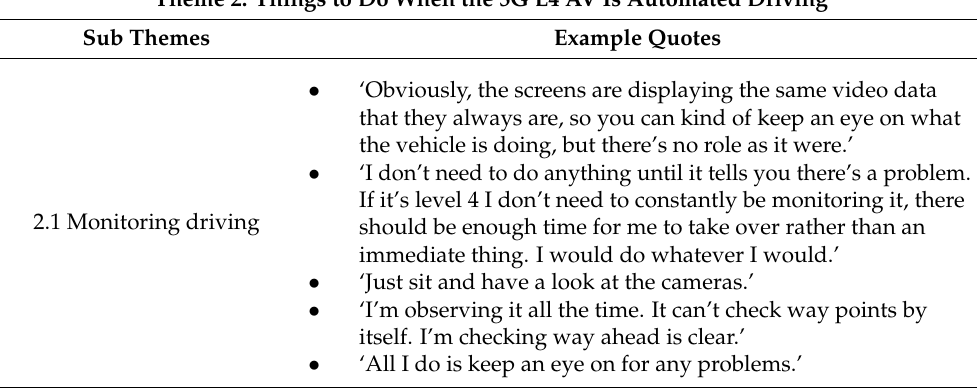
Table 2. Theme 2: Things to do when the 5G AV is automated driving. Theme 2: Things to Do When the 5G L4 AV Is Automated